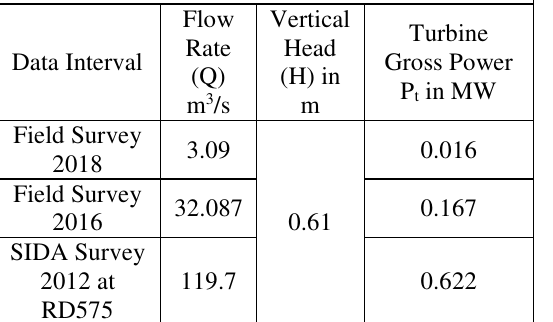
TABLE 4: TURBINE GROSS POWER CALCULATED FOR THE THREE STUDIES: Data Interval